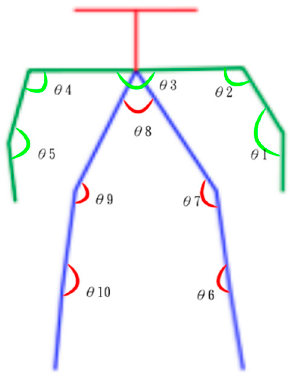
Figure 2. Joint angle diagram.